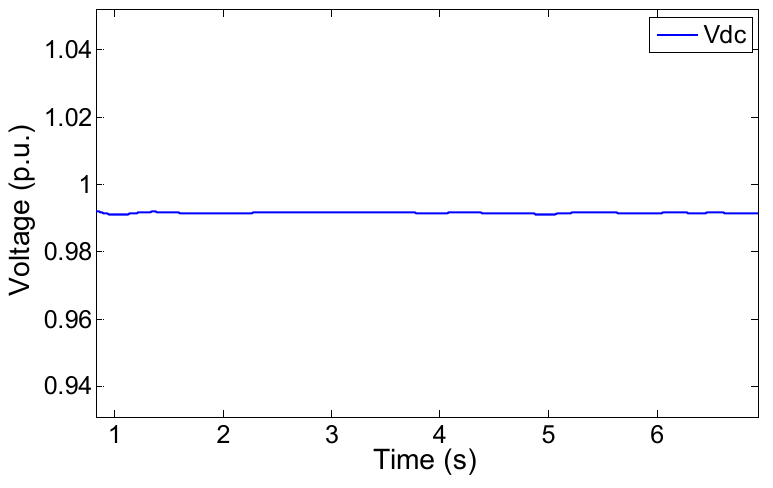
Figure 26. DC voltage in the second case, when ∆(cid:1842) was not limited.